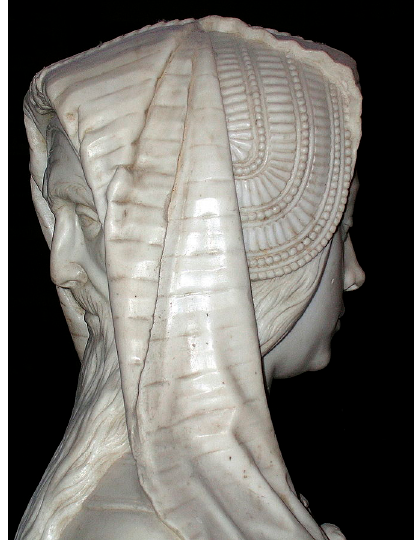
Figure 2. Side view of Colombe’s Prudence. 12